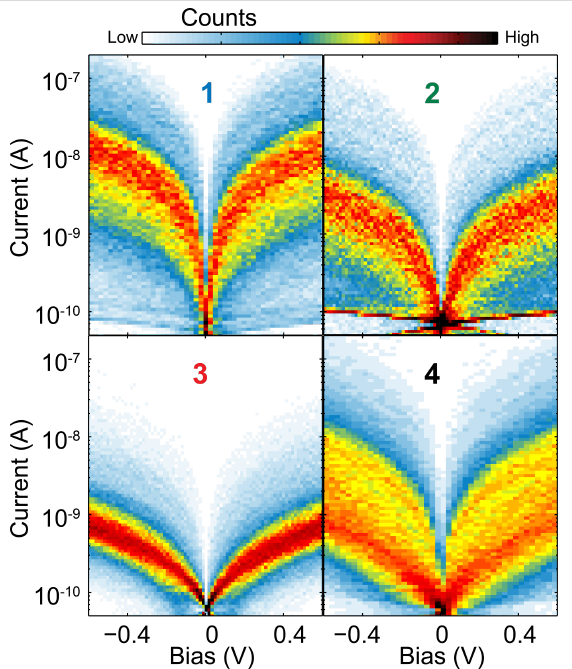
Figure 5: Two-dimensional color map plots of all the I – V s measured on molecules 1 – 4 . The bias axis is linearly binned with 40 bins/V and the current is logarithmically binned with 25 bins/decade.